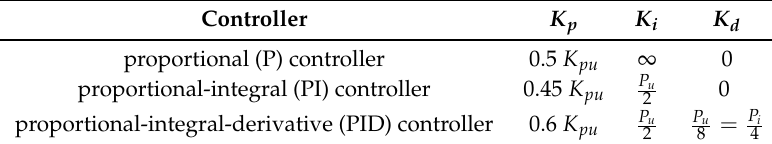
Table 3. Conditions for the controller parameters in the Ziegler–Nichols’ closed loop technique.